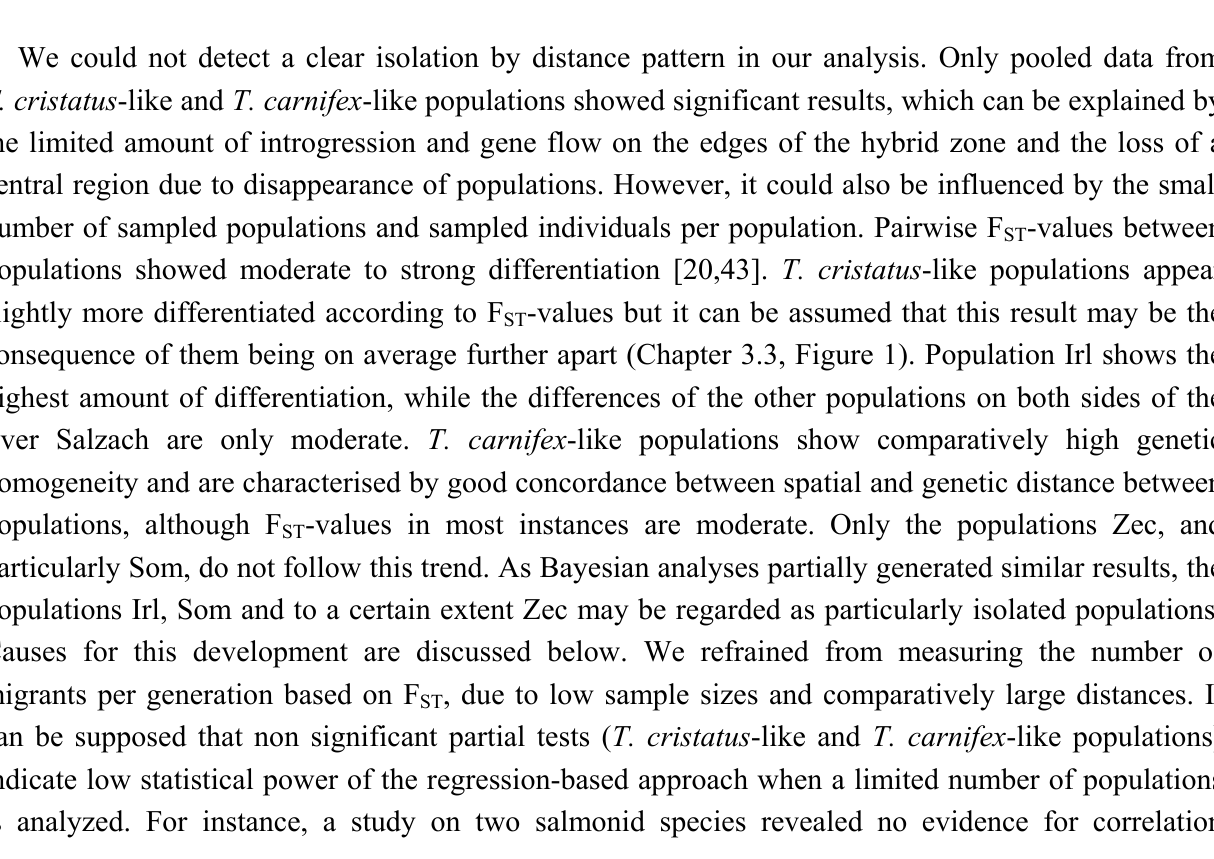
, lower triangle) and ST -values are significant unless indicated ST